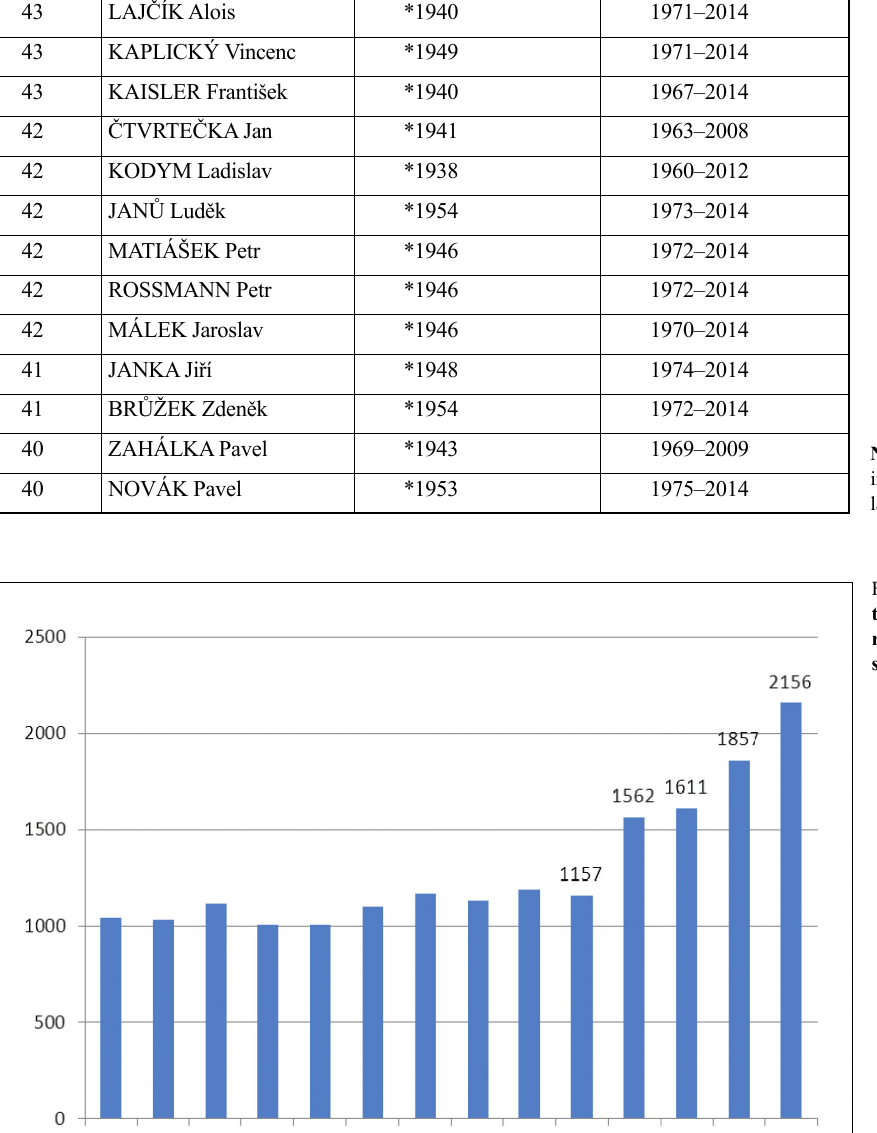
Table 1. The top of the list of so called “loyal” runners with